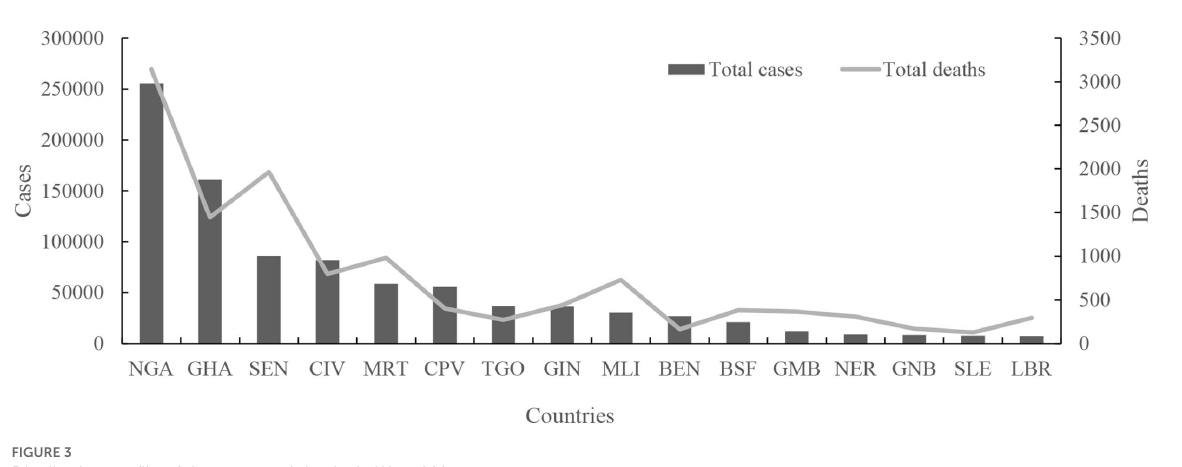
FIGURE3 Distribution profile of the cases and deaths in West